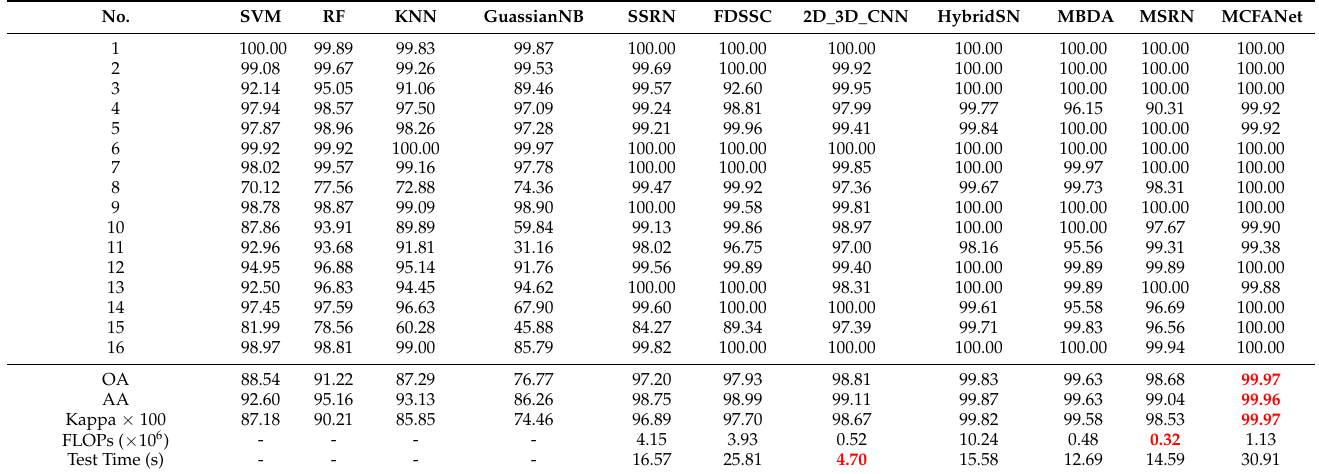
Table 6. The classification accuracies of comparison approaches on the SA